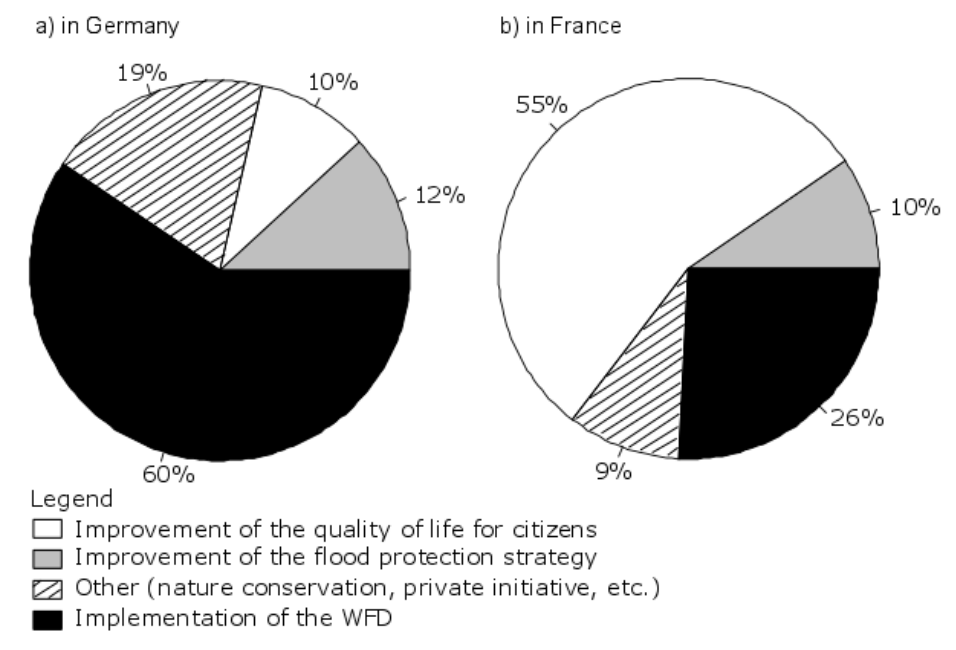
Figure 2. Pie chart of the main project motivations ( a ) in Germany, and ( b ) in France.